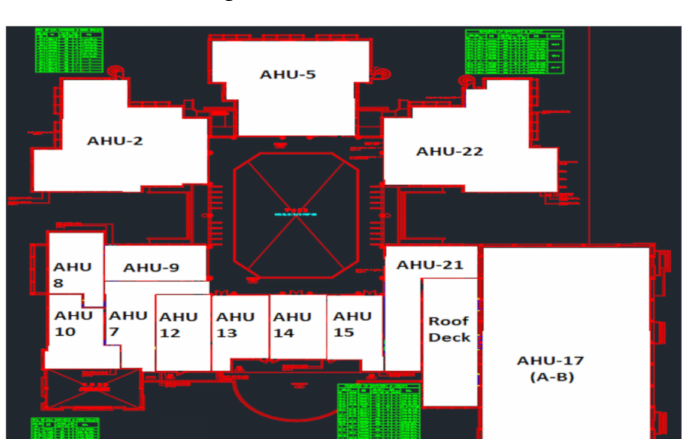
Figure A4. School first floor.